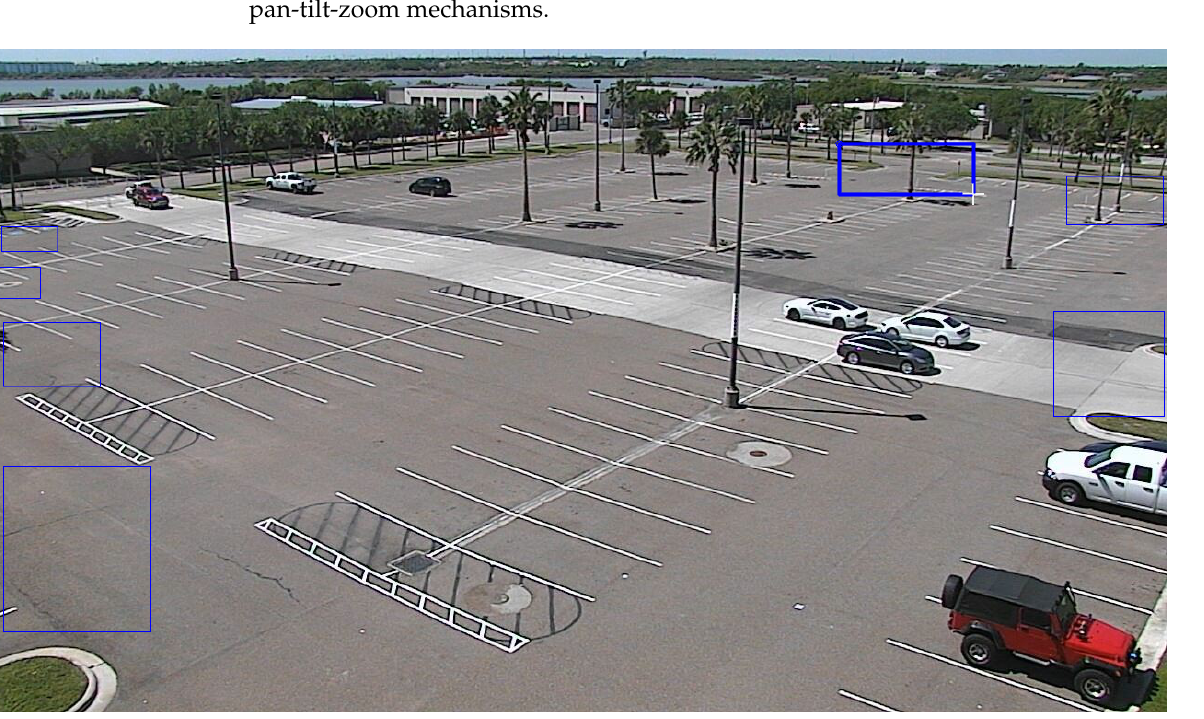
Figure 2. View of the study area from the perspective camera. Regions of the image where vehicle ingress/egress are expected are outlined in blue—there is no significance to the box thickness around each region, it is an artifact of the GUI tool developed to accelerate region